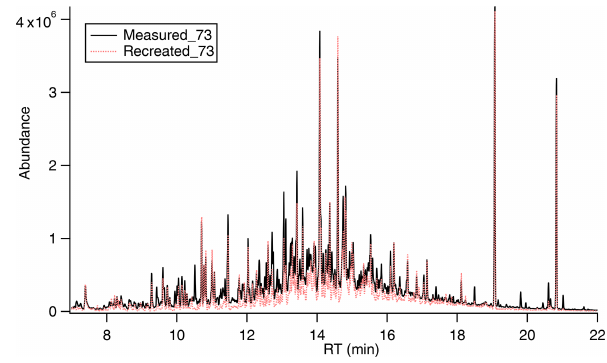
Figure 2. Highly complex mixture of canola oil SOA generated upon photooxidation. With known signal and mass fragmentation, the signal of m/z 73 can be recreated based on pseudo-parent ions (e.g., M-15 used in this